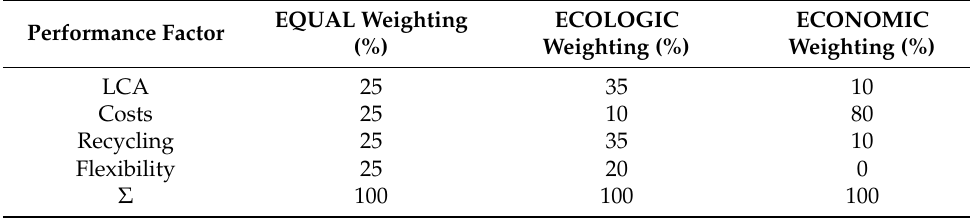
Table 3. Applied weighting scenarios in the variant study.